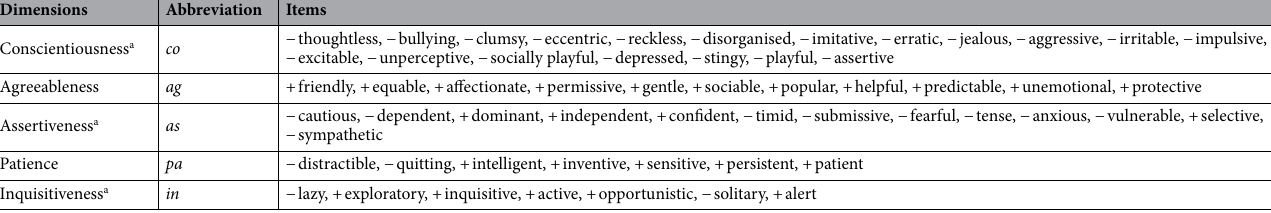
Table 1. Common marmoset’s personality structure derived from questionnaire ratings based on Koski et al. 40 . The resulting personality structure comprises five dimensions (personality traits) characterised by a list of adjectives (items). Positive and negative loadings of items are indicated by + and −, respectively. Each individual then acquires a personality score describing variation between individuals on each dimension, e.g. from less (low score) to more (high score) agreeable individuals. a Loadings reversed to facilitate the interpretation, see 40